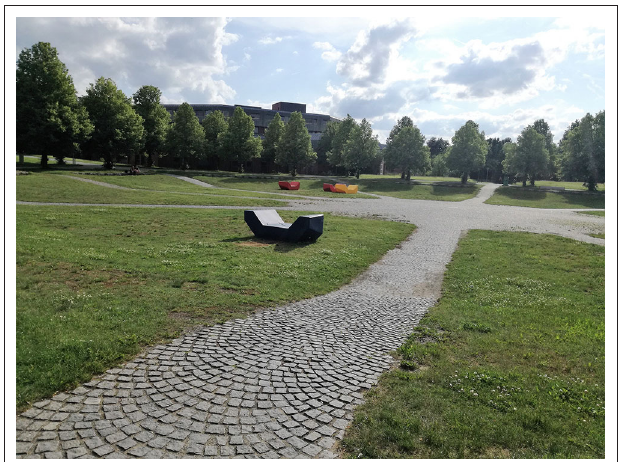
FIGURE 4 | The round structure of the campus, with the faculties located on the side of the circle, are inviting to go for a walk. Shaded by trees, the students can stroll around during their break (Photo: U1 S6).